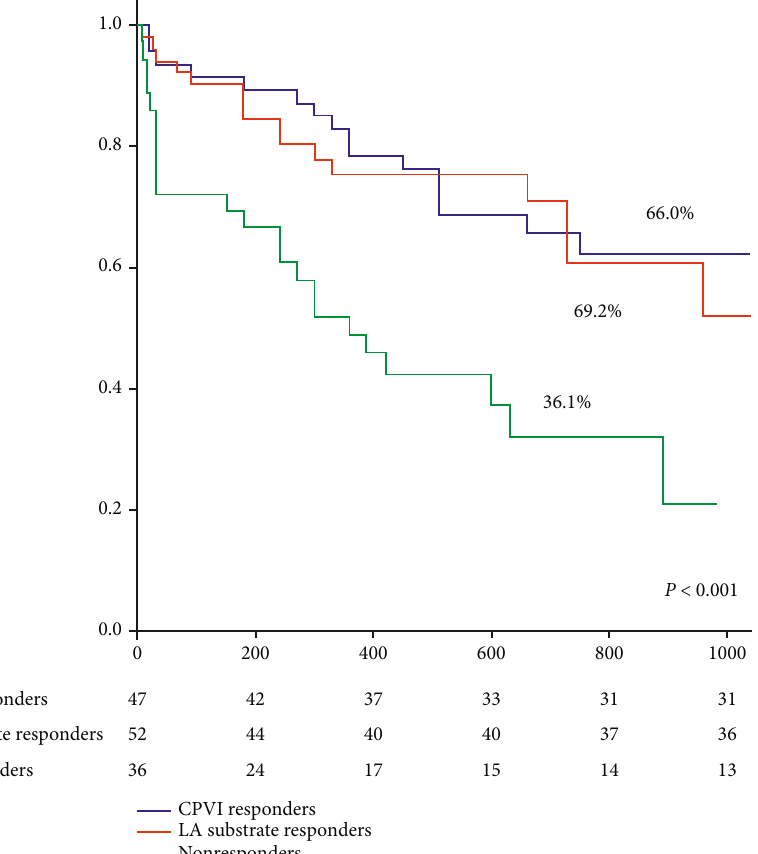
Figure 5: Kaplan–Meier plots depicting atrial tachyarrhythmia-free survival at 2 years after the first procedure. Persistent atrial fibrillation (AF) was terminated by circumferential pulmonary vein isolation (CPVI) alone (blue line), CPVI combined with left atrial modification guided by low-dose ibutilide (red line), and cardioversion (CV) (green